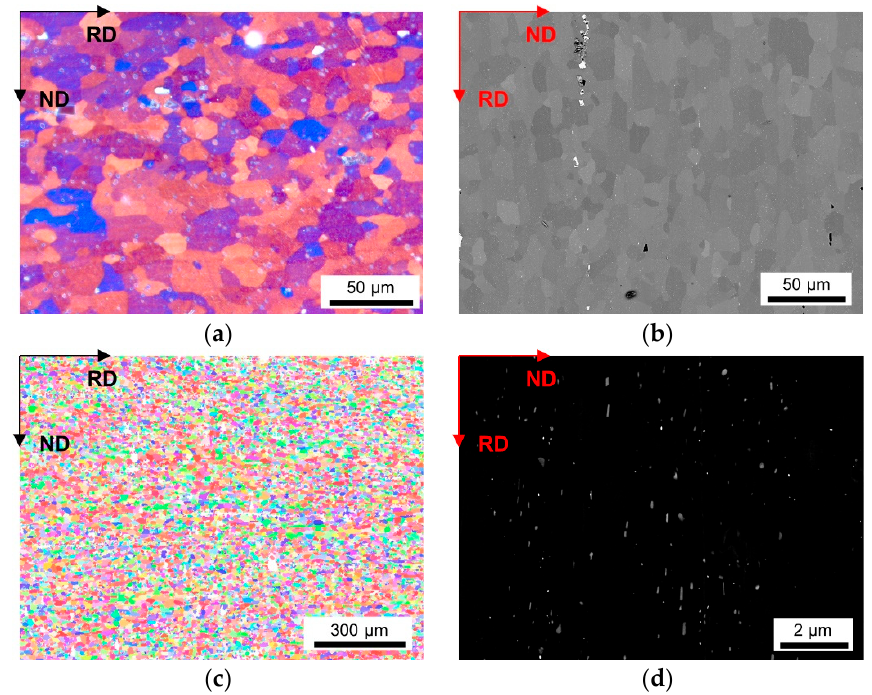
Figure A9. Microstructure of the soft annealed LFe-HMn cast under S-C condition, homogenized at 500 °C and cold rolled to a CRD of 63%. ( a ) LOM. ( b ) BSE image. ( c ) EBSD IPF map in RD–ND plane. ( d ) BSE micrograph showing dispersoids.